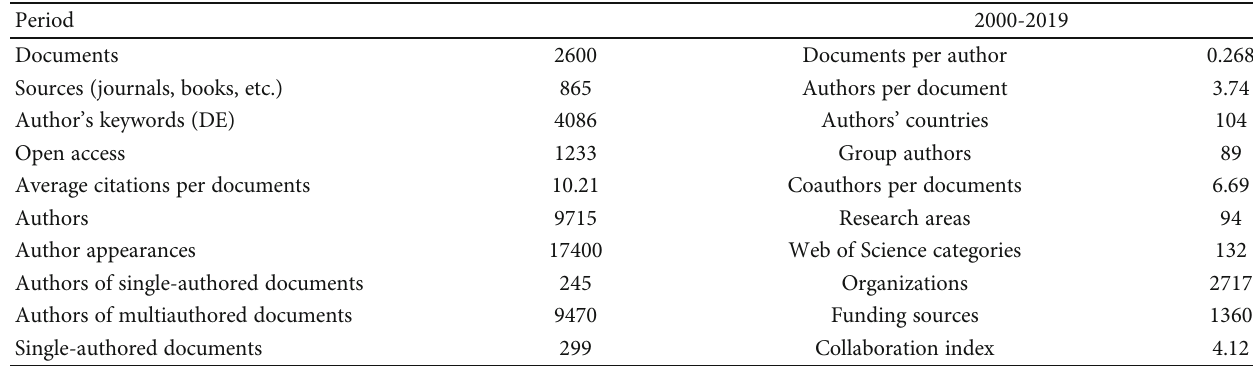
Table 1: Summary